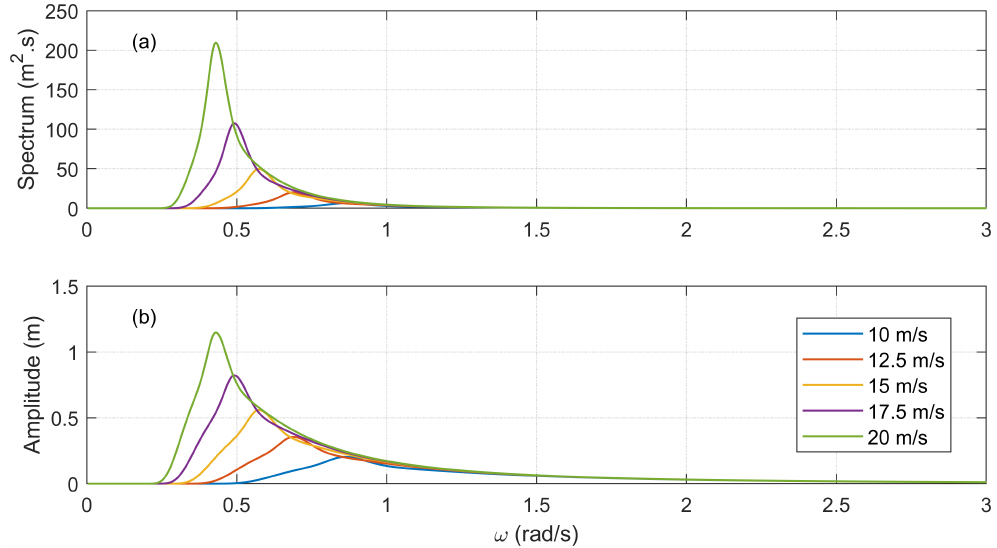
Figure 6. JOHNSWAP wave spectra under different wind speeds: ( a ) Surface elevation spectrum; ( b ) Amplitude of ocean